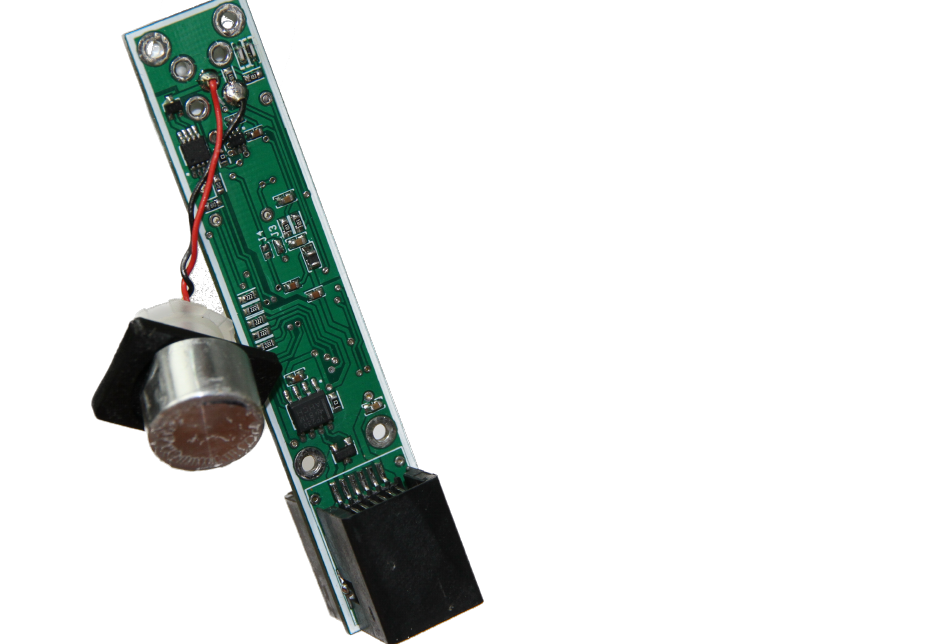
Figure 4. The internals of active probe of a UST used in the